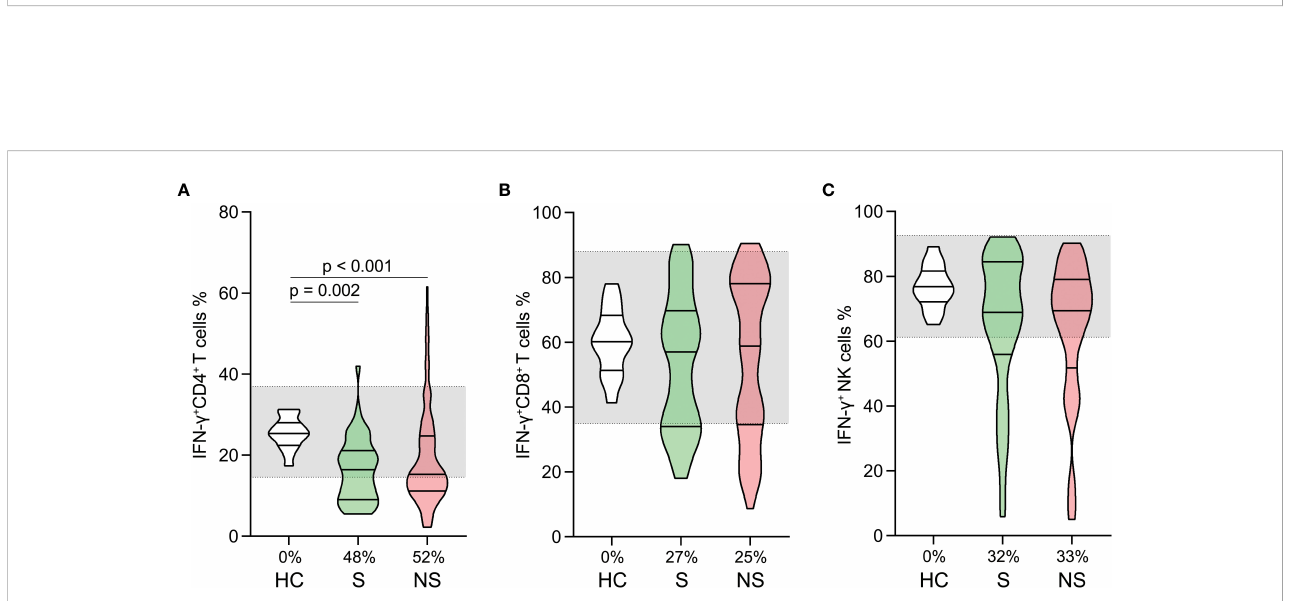
FIGURE 5 Changes in lymphocyte functions in patients with septic shock. The proportions of PMA/ionomycin-stimulated IFN- g positive cells in CD4 + T cells (A) , CD8 + T cells (B) , and Natural killer (NK) cells (C) were compared among healthy controls, survivors, and nonsurvivors. The shaded region represents the normal value range. The proportions of patients whose test results are below the lower limit of the normal range are shown on the x-axis (A – C)